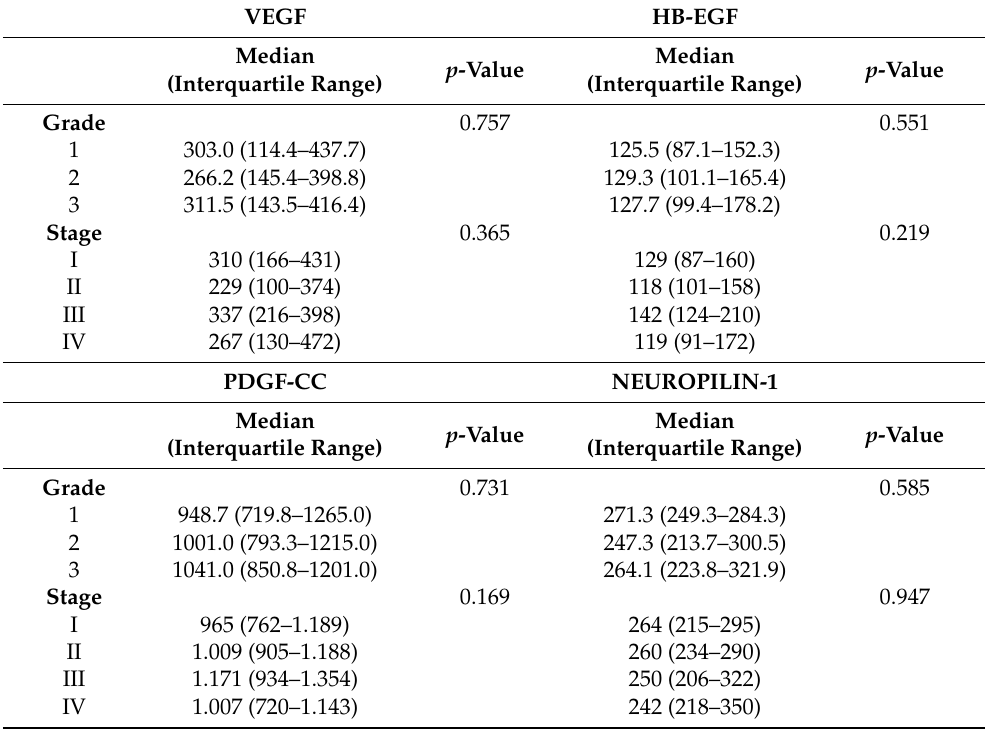
Table 3. Correlation of VEGF, HB-EGF, PDGF-CC and neuropilin-1 expression levels with tumor grade and stage of